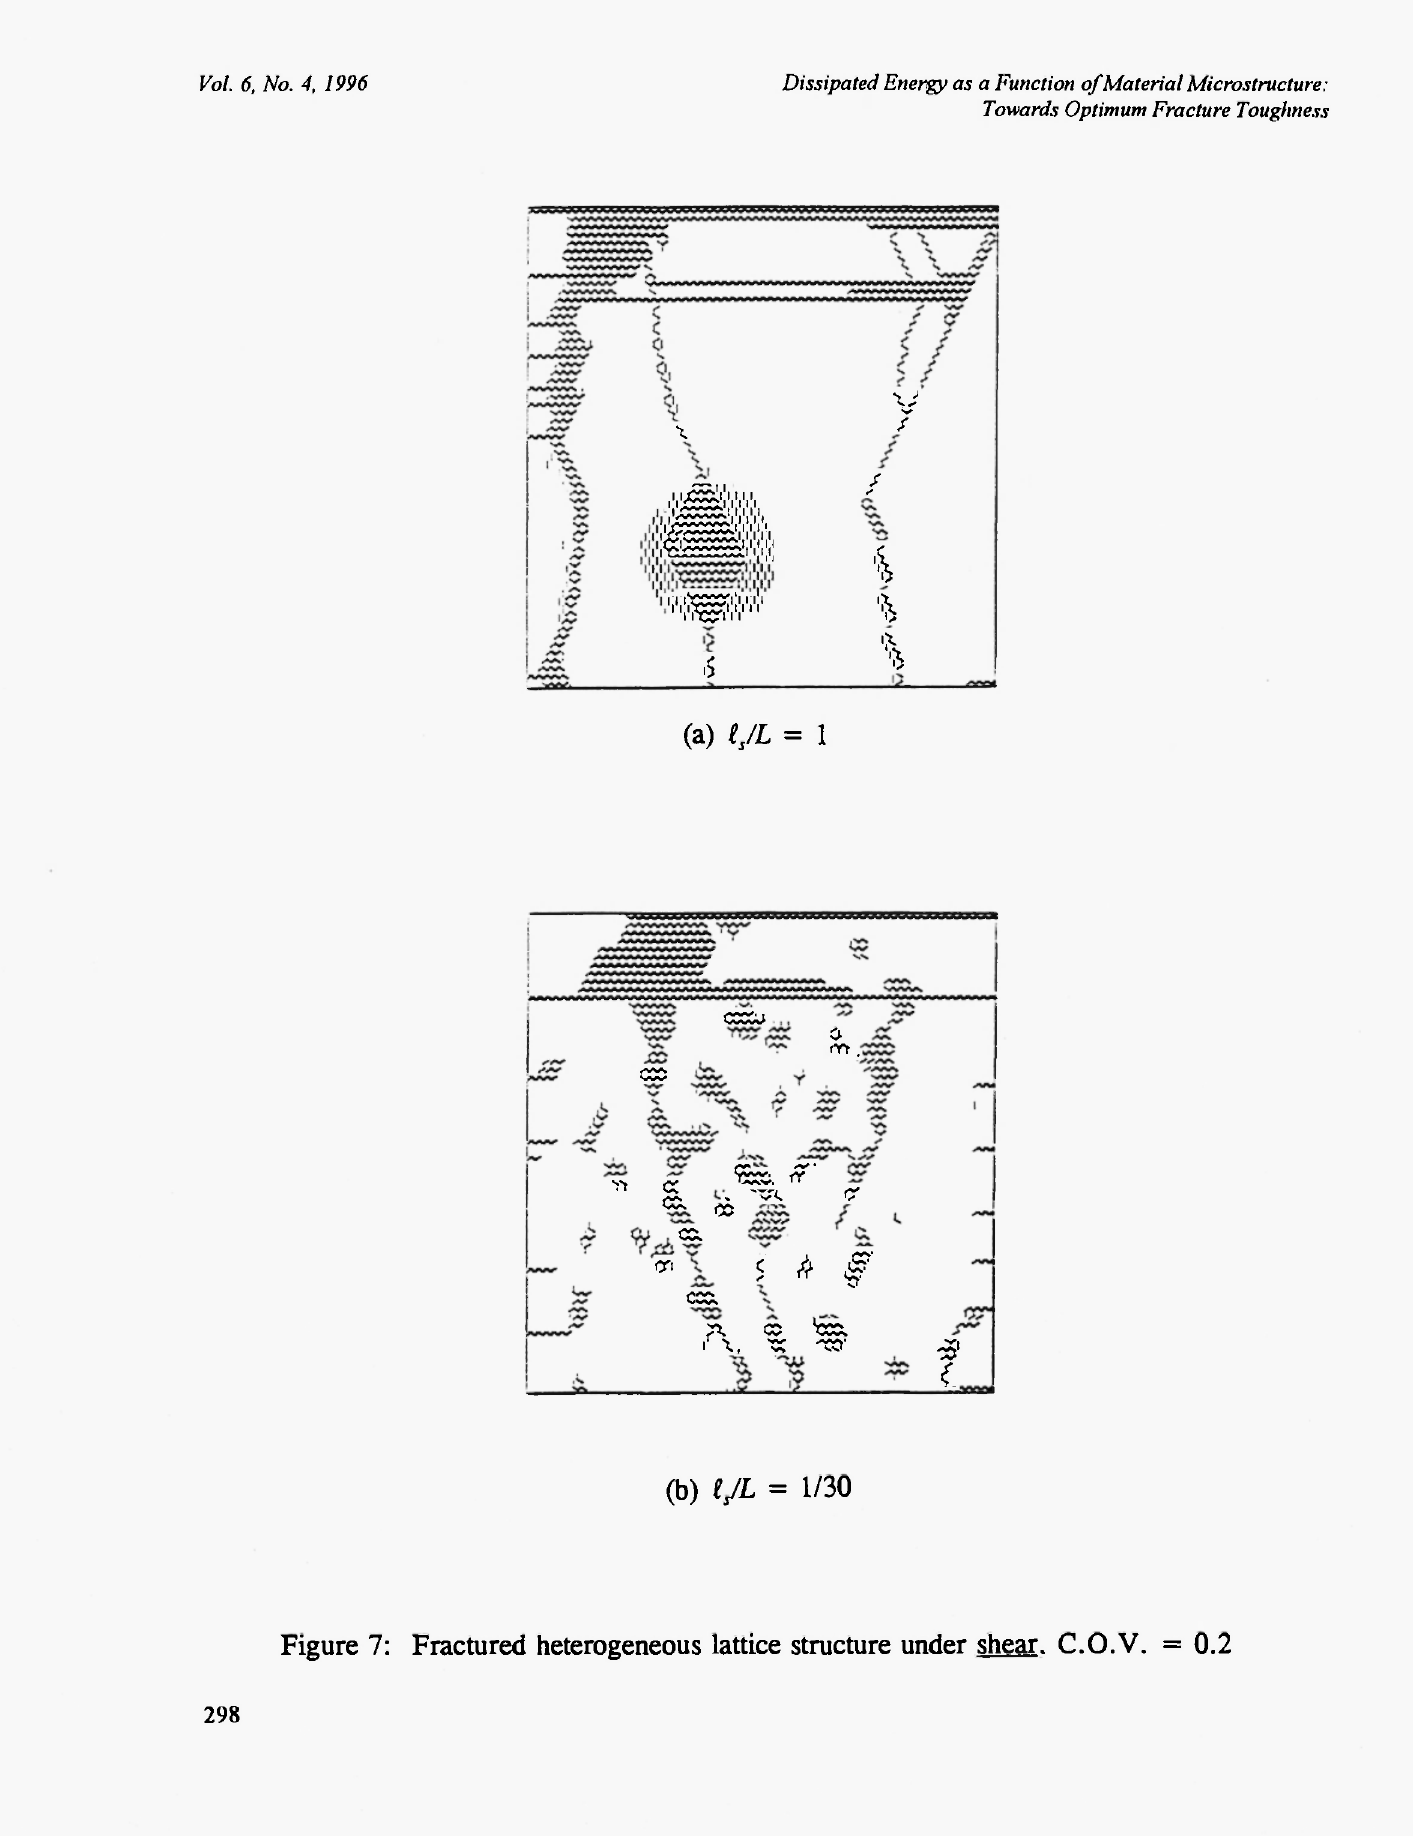
Figure 7: Fractured heterogeneous lattice structure under shear. C.O.V. =